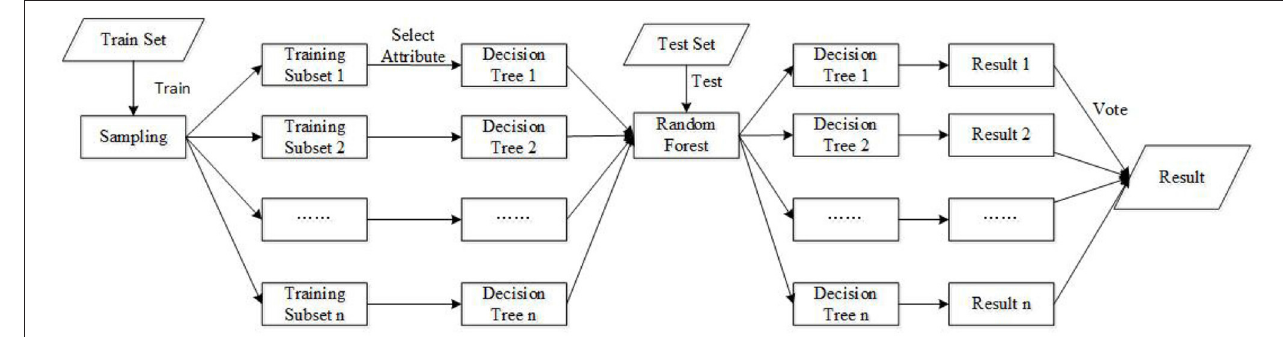
FIGURE 3 | The principle of improved random forest